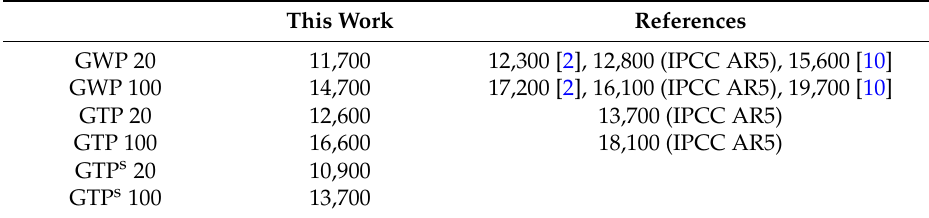
Table 4. A comparison of global warming potential (GWP), global temperature potential (GTP), and sustained changes in GTP (GTP s ) results of this work relative to those of other works. This